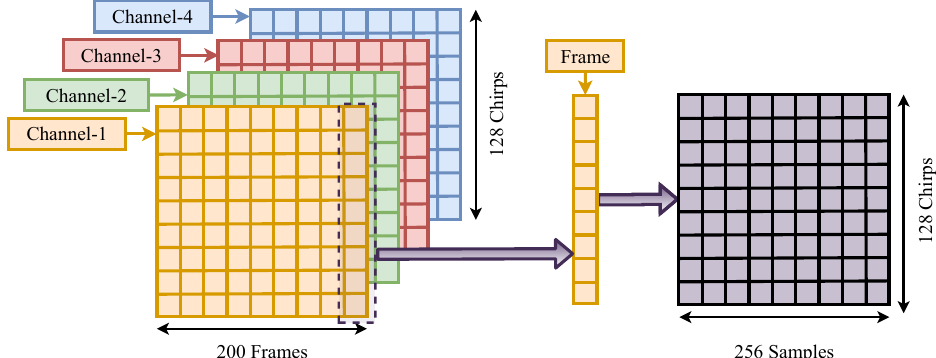
Figure 4. Details of frame structure.